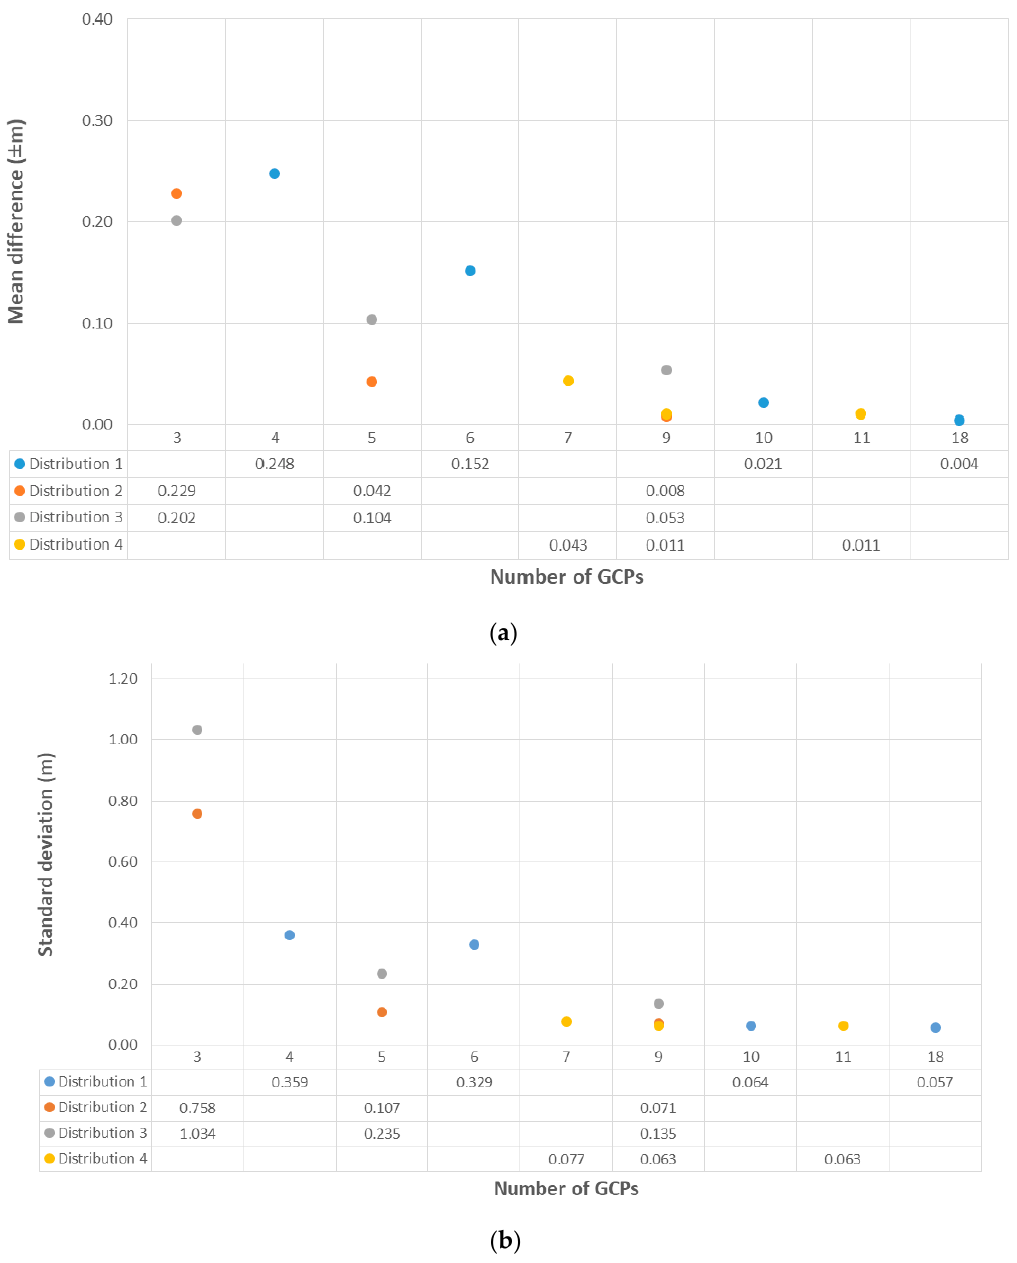
Figure 11. Multiscale Model to Model Cloud Comparison (M3C2) distance measurements between the reference cloud and the clouds obtained from the different photogrammetric projects carried out. ( a ) Mean difference (accuracy); ( b ) standard deviation (precision).